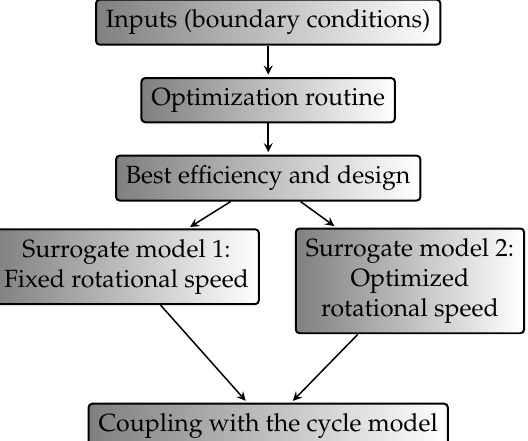
Figure 4. Diagram illustrating the expander optimization procedure and integration with the cycle